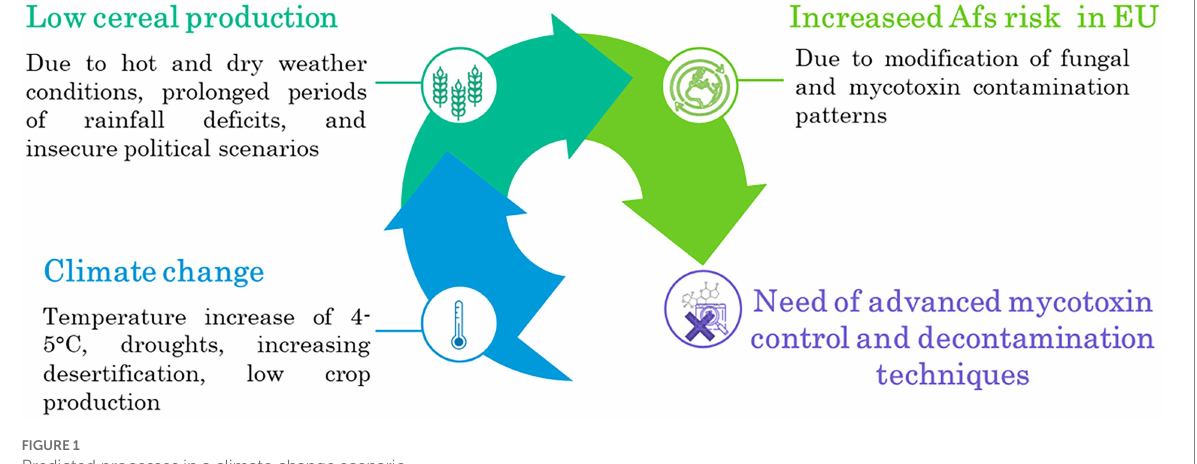
FIGURE 1 Predicted processes in a climate change